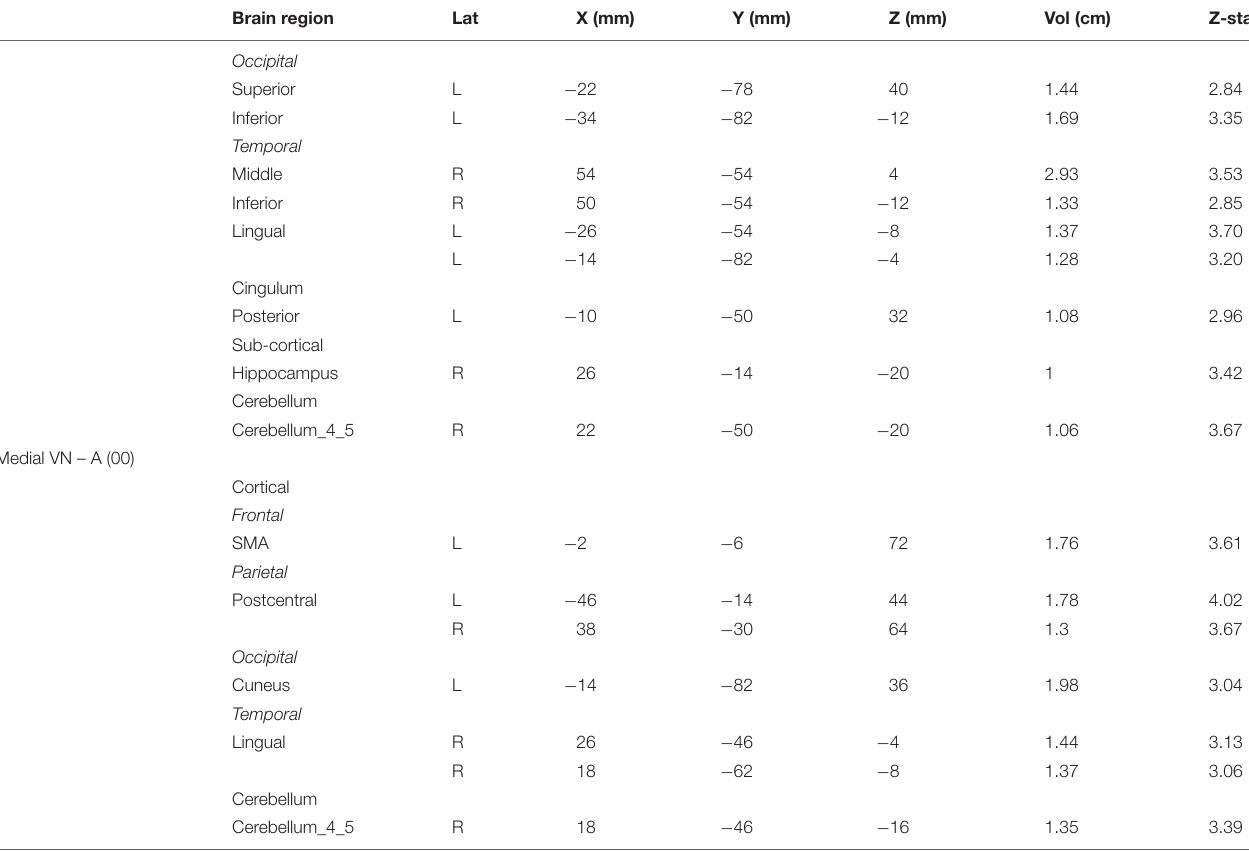
The table indicates brain areas of significant increased connectivity with the listed networks for adolescents with migraine vs. young adults with migraine and healthy controls. Coordinates and max statistical value (z-stat) are given for peak activity as well as volume (Vol) of each cluster of activity. “Lat” indicates the brain laterality (i.e., R, right side, L, left